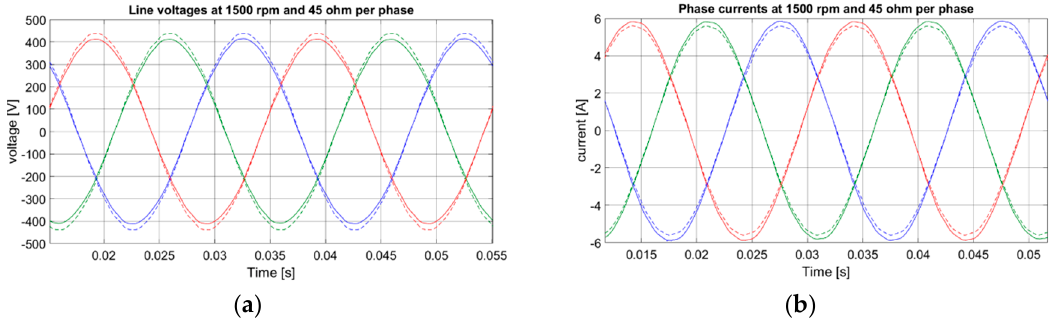
Figure 11. Loaded PMSG: ( a ) line voltages and ( b ) currents; dotted lines are FEA results.